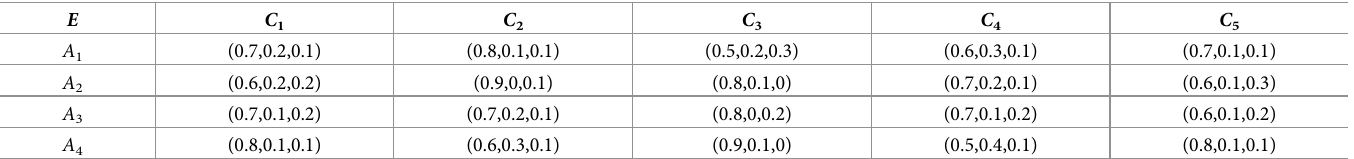
ffiffiffiffiffiffiffiffiffi p 0 : 06 p 0 : 08 ffiffiffiffiffiffiffiffiffi p 0 : 02